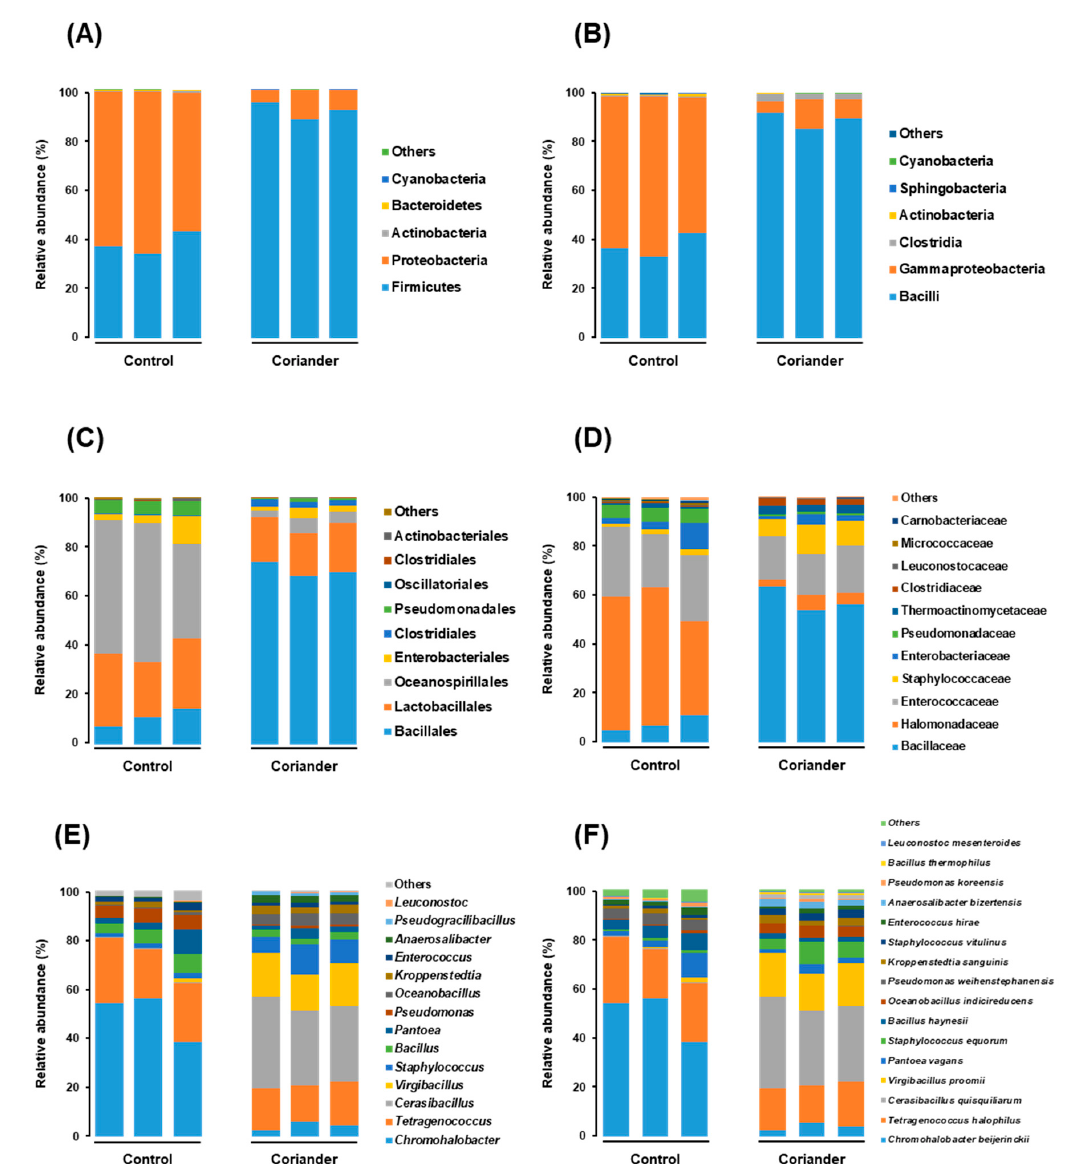
Figure 3. Stacked bar graphs representing the microbiome structure in soy sauce samples prepared by adding coriander, compared to that of control: ( A ) phylum level, ( B ) class level, ( C ) order level, ( D ) family level, ( E ) genus level, and ( F ) species level.